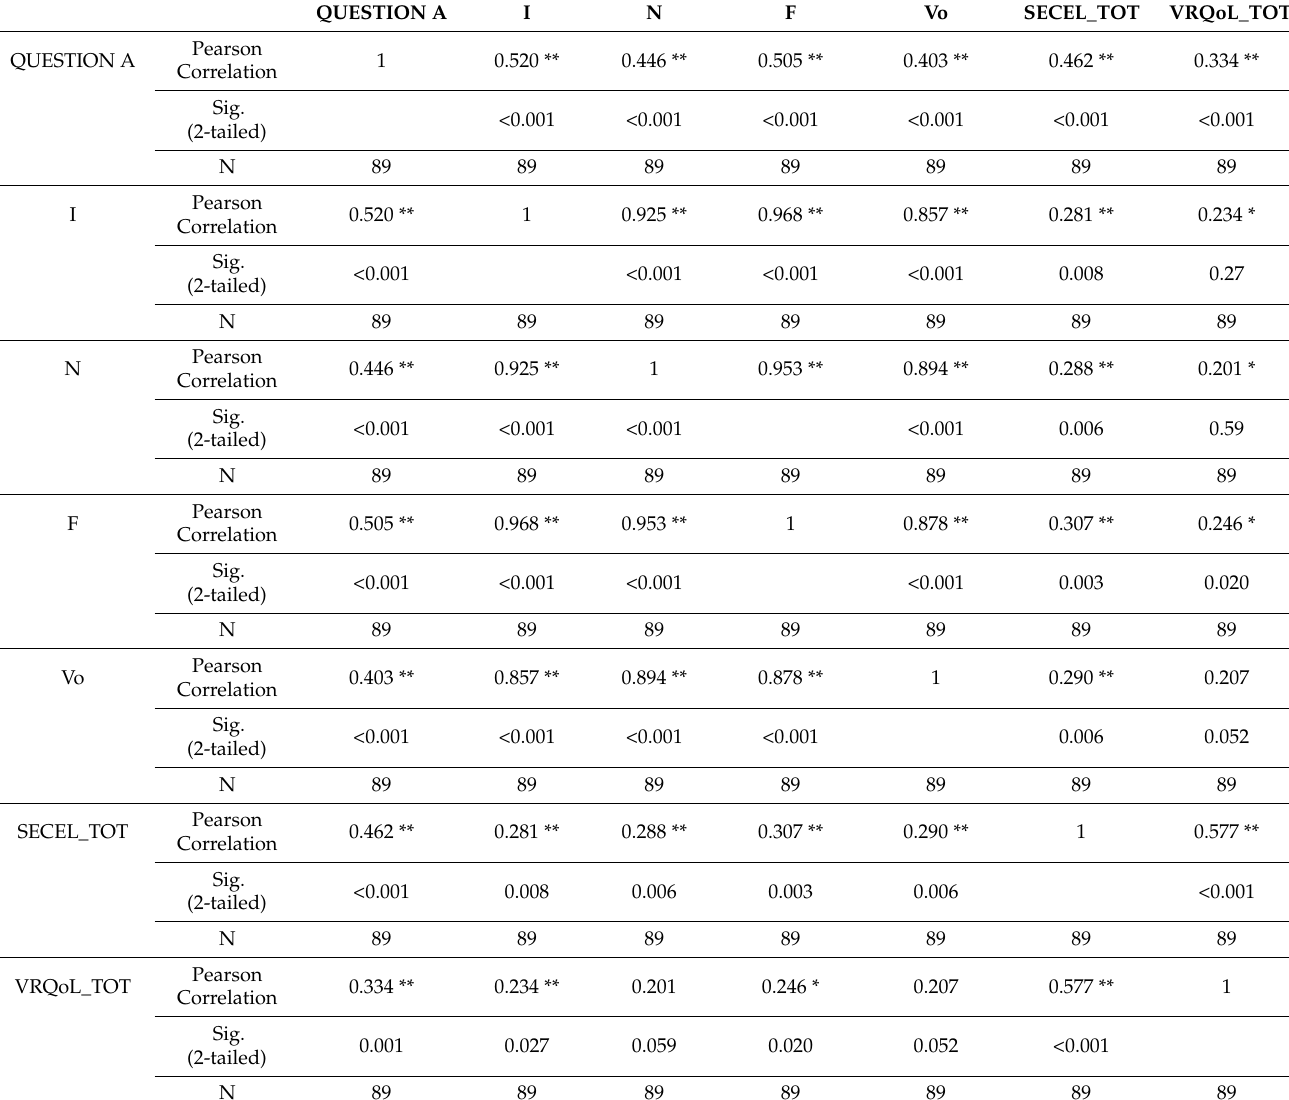
Table 6. Correlation